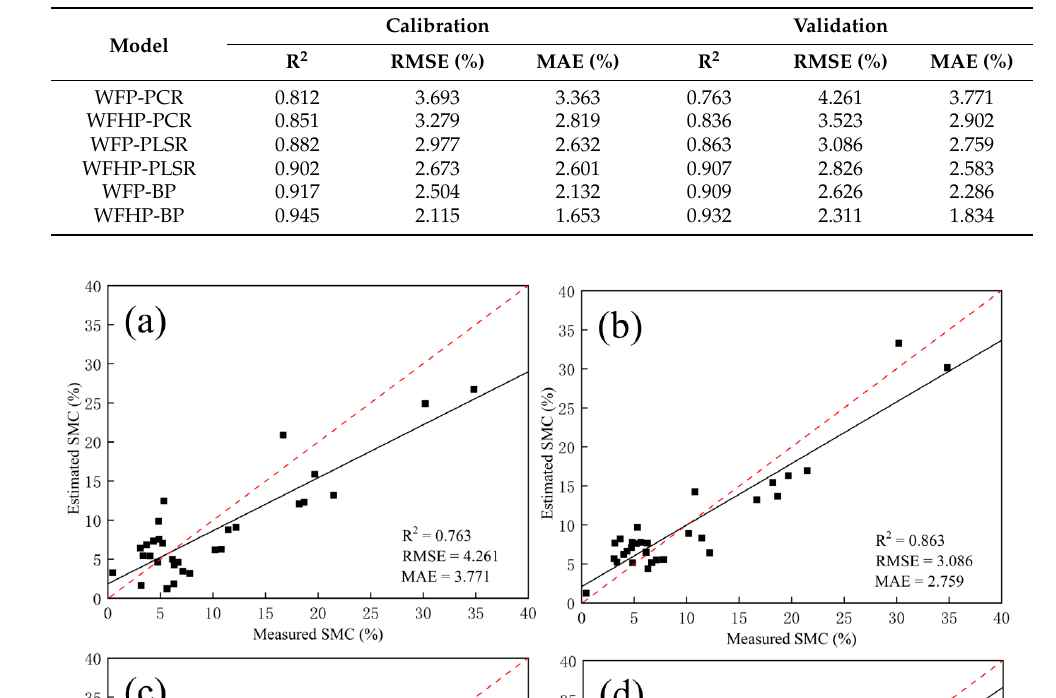
Table 4. Accuracy comparison of different regression models.